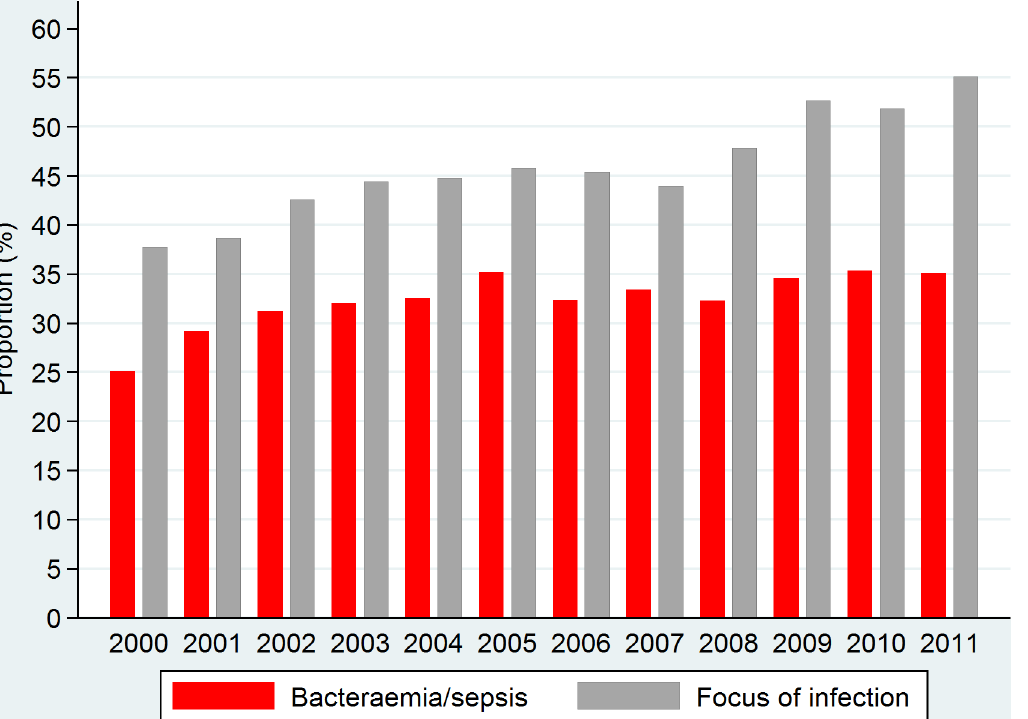
Fig 1. Annual proportions of bacteraemia episodes captured by ICD-10 or NOMESCO codes designating “ Bacteraemia/sepsis ” or “ Focal infection ” , 2000 – 2011.